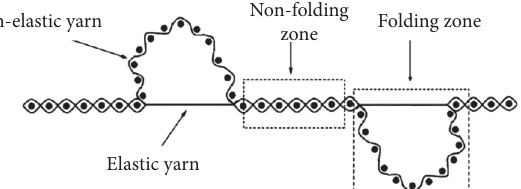
Figure 5: Schematic diagram of fabric latitudinally-trending fold formation.